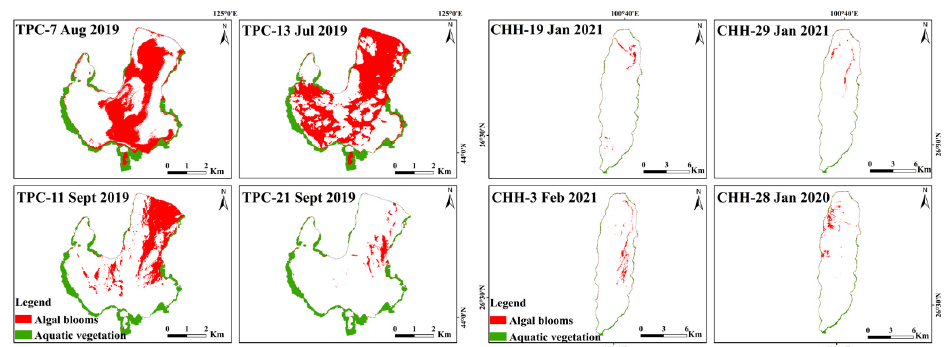
Figure 10. Identification results of algal blooms and aquatic vegetation in nonmodeled lakes. TPC is Taipingchi Reservoir and CHH is Lake Chenghai. TPC-7 August 2019 means the image identification result of Taipingchi Reservoir on 7 August 2019, and so on for the letter and number meanings following other lake abbreviations. Table 3. The number of validation points and the calculated accuracy results for the extent of aquatic vegetation and the extent of nonaquatic vegetation buffered outwards for Taipingchi Reservoir and Lake Chenghai are shown.